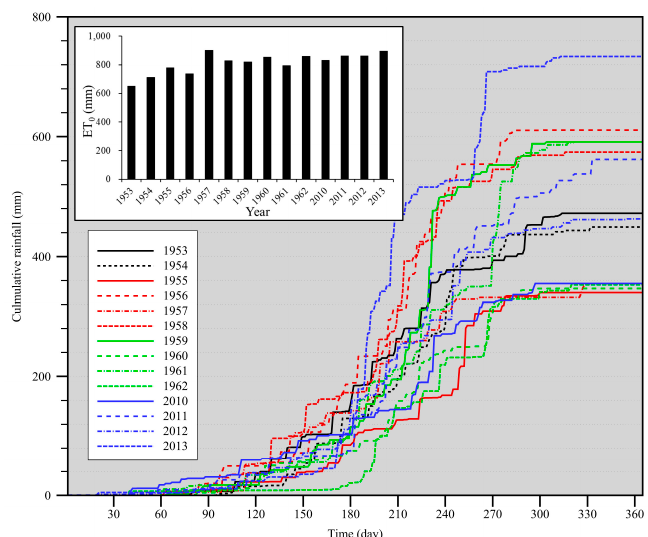
Figure 4. Measured cumulative rainfall for the 14 simulating years. The inset is the annual potential evapotranspiration (ET 0 ) calculated by the revised Penman-Monteith method.